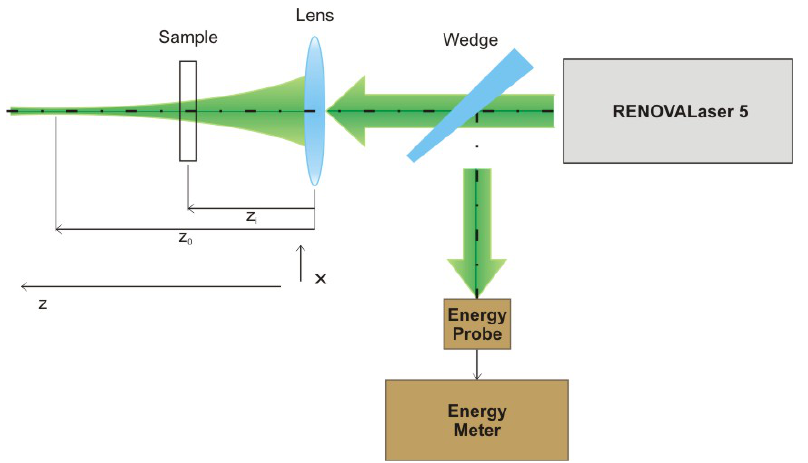
Figure 47. Experimental setup for determination of substrate ablation damage